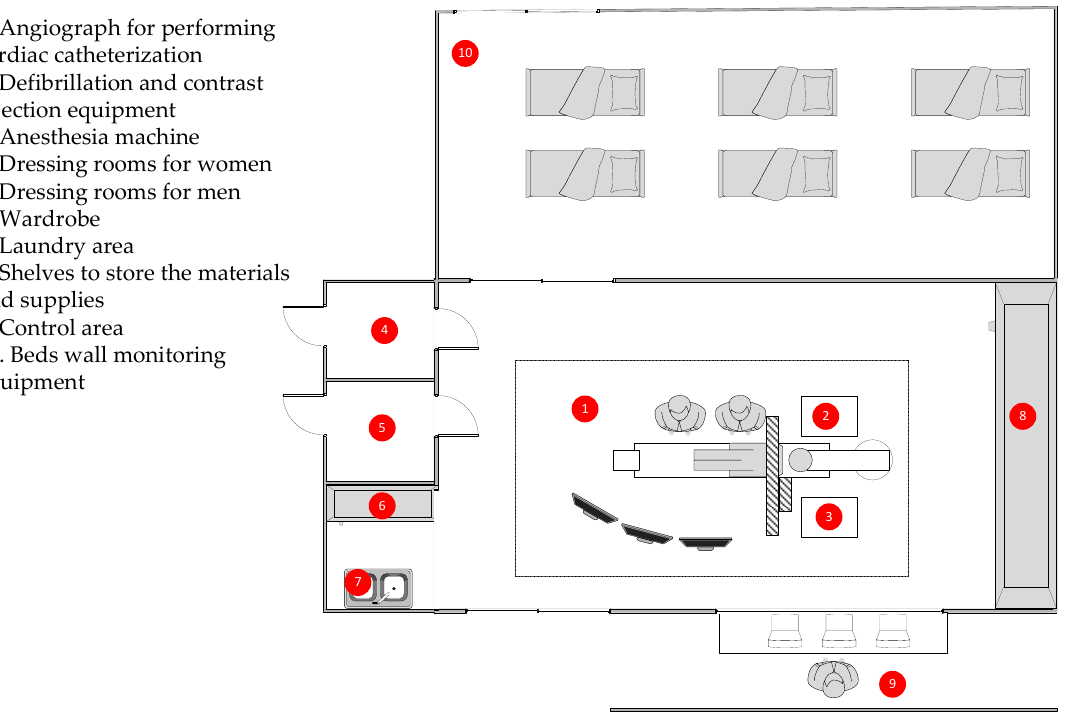
Figure 1. Floor map for the angiography room.